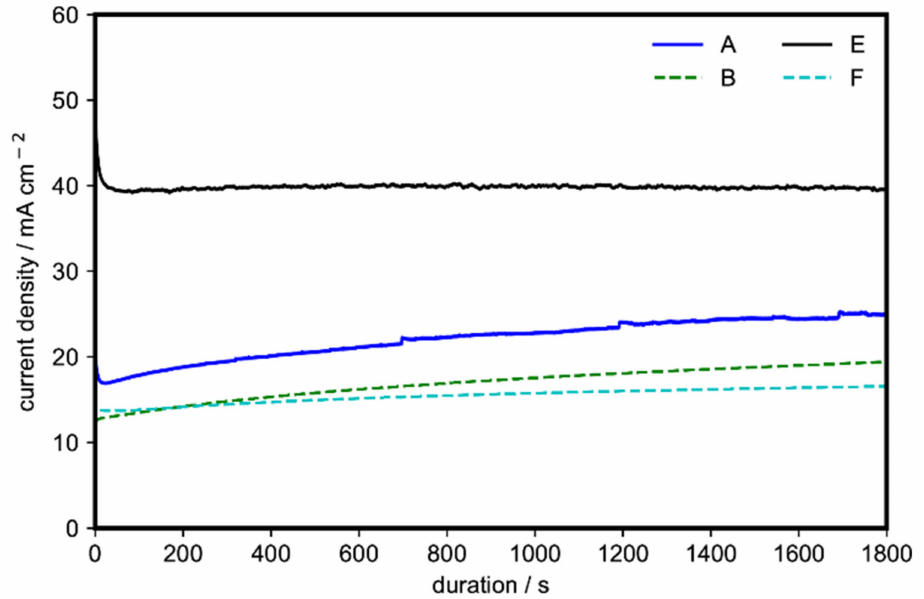
Figure 4. Chronoamperometry at a constant applied potential of 1.55 V (vs. RHE) of four representative morphologies of Ni(OH) 2 for 30 min on 1 M ethanol and 1 M